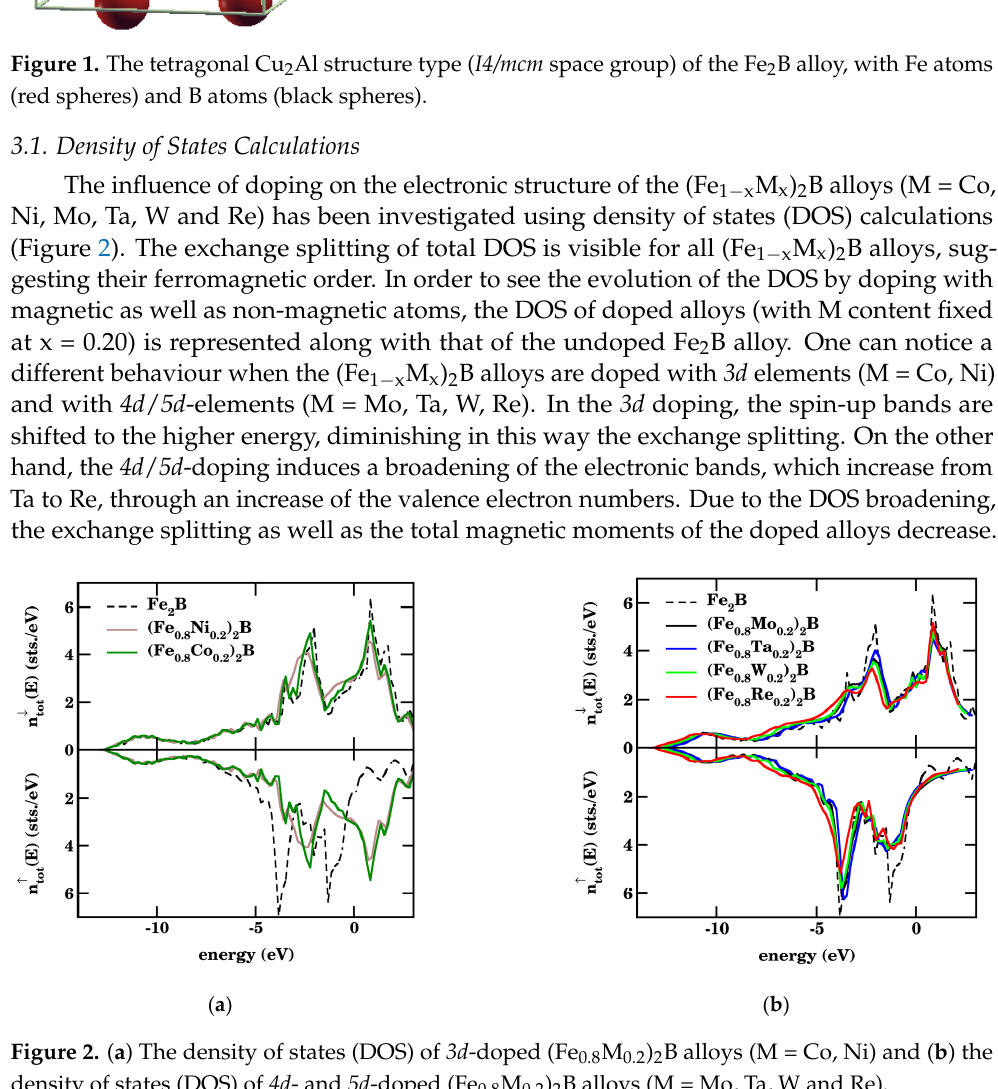
Figure 1. The tetragonal Cu 2 Al structure type ( I4/mcm space group) of the Fe 2 B alloy, with Fe atoms (red spheres) and B atoms (black spheres).